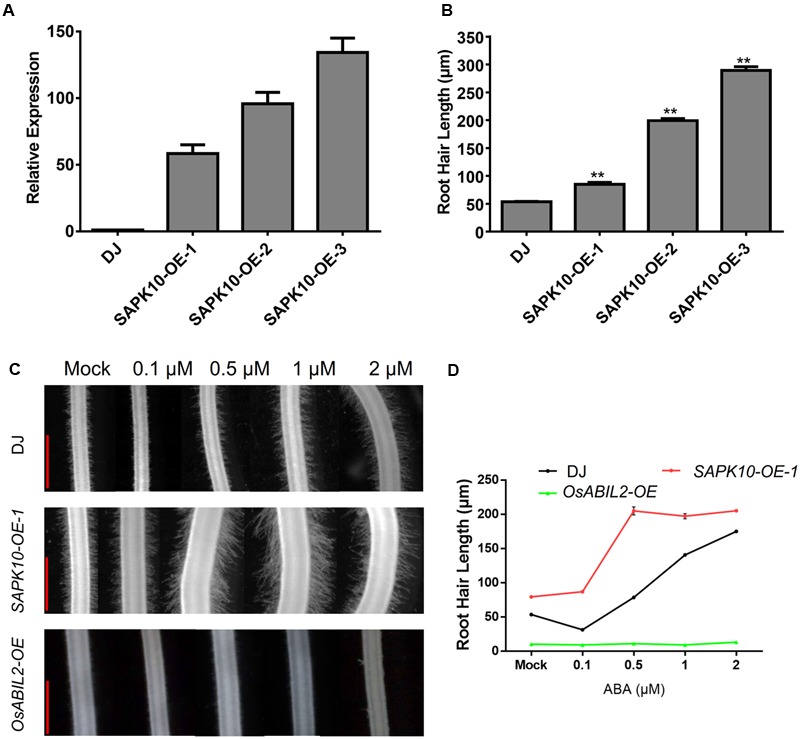
ABA-induced root hair elongation is dependent on ABA signaling. (A) Expression level of SAPK10 in the SAPK10-OE lines determined by quantitative RT-PCR. Seven-day-old roots were used. (B) Root hair length of the SAPK10-OE line. The root hairs located about 4–5 mm from the root apex were measured. About 20 longest root hairs from each of the 15 crown roots were measured. Data are means ± SE. (C) Root hair morphology of the wild type, and the SAPK10-OE-1 and OsABIL2-OE transgenic lines. Five-day-old seedlings were treated with different concentrations (0, 0.1, 0.5, 1, and 2 μM) of ABA for 24 h. Scale bar = 500 μm. (D) Quantification of root hair length of the wild type, SAPK10-OE, and OsABIL2-OE lines. Data are means ± standard error (SE).